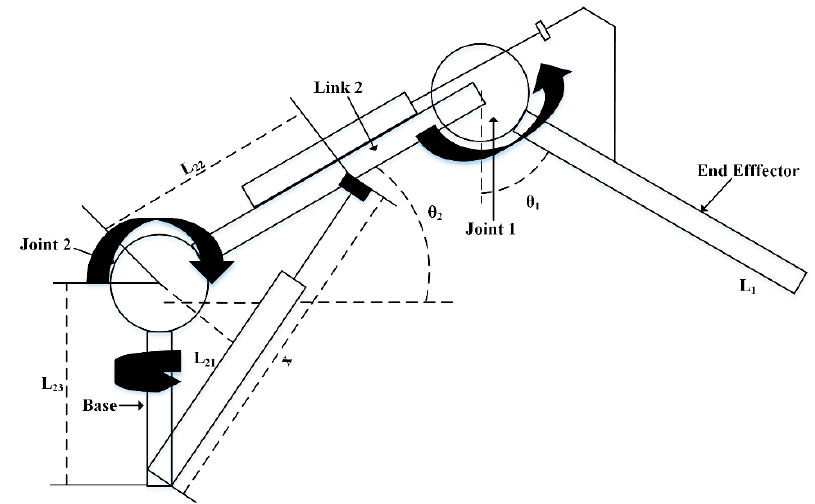
Figure 2. Schematic diagram of the base, 2 nd link and end effector.